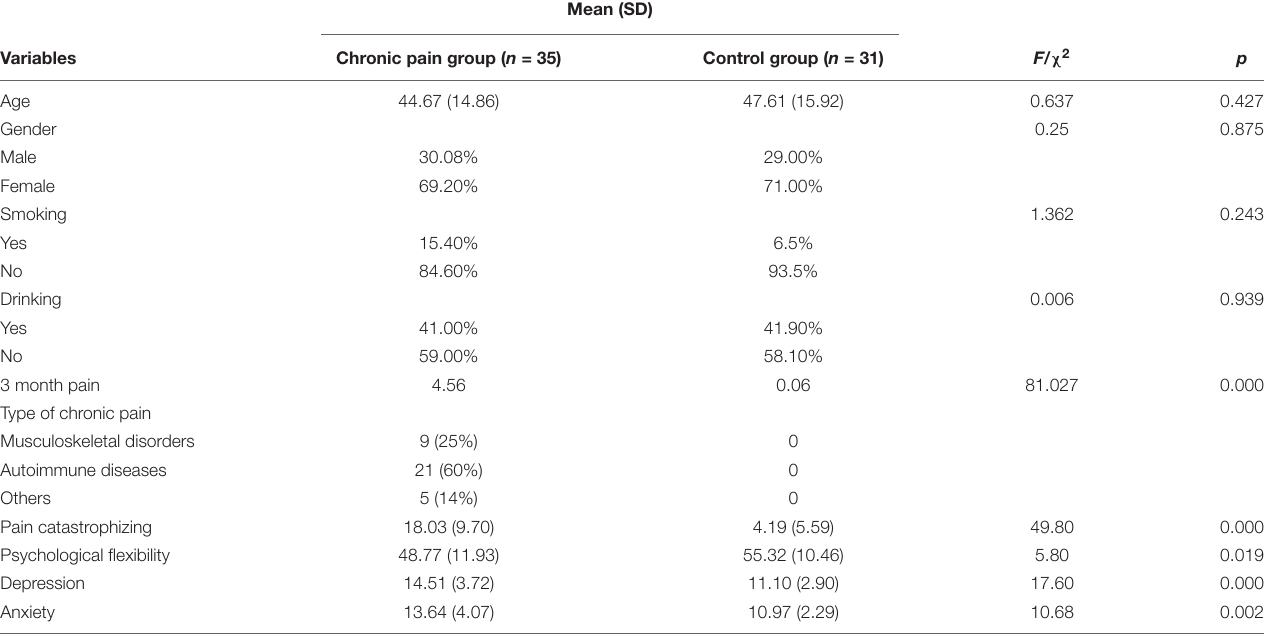
TABLE 1 | Descriptive statistics of demographic information and psychological variables by two groups.